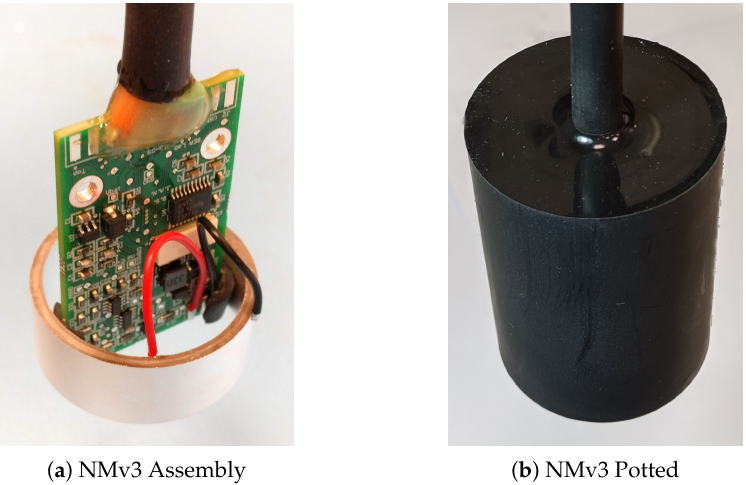
Figure 13. NMv3 acoustic modem showing ( a ) the PCB and crystal assembly and ( b ) the final potted modem.